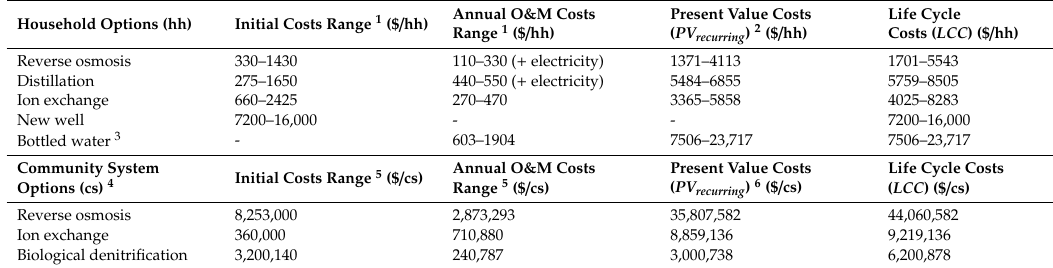
Table 4. Estimated cost per household (hh) of Point-of-Use (POU) treatment (above) and per community system (cs) of Point-of-Entry (POE) treatment (below) for nitrate